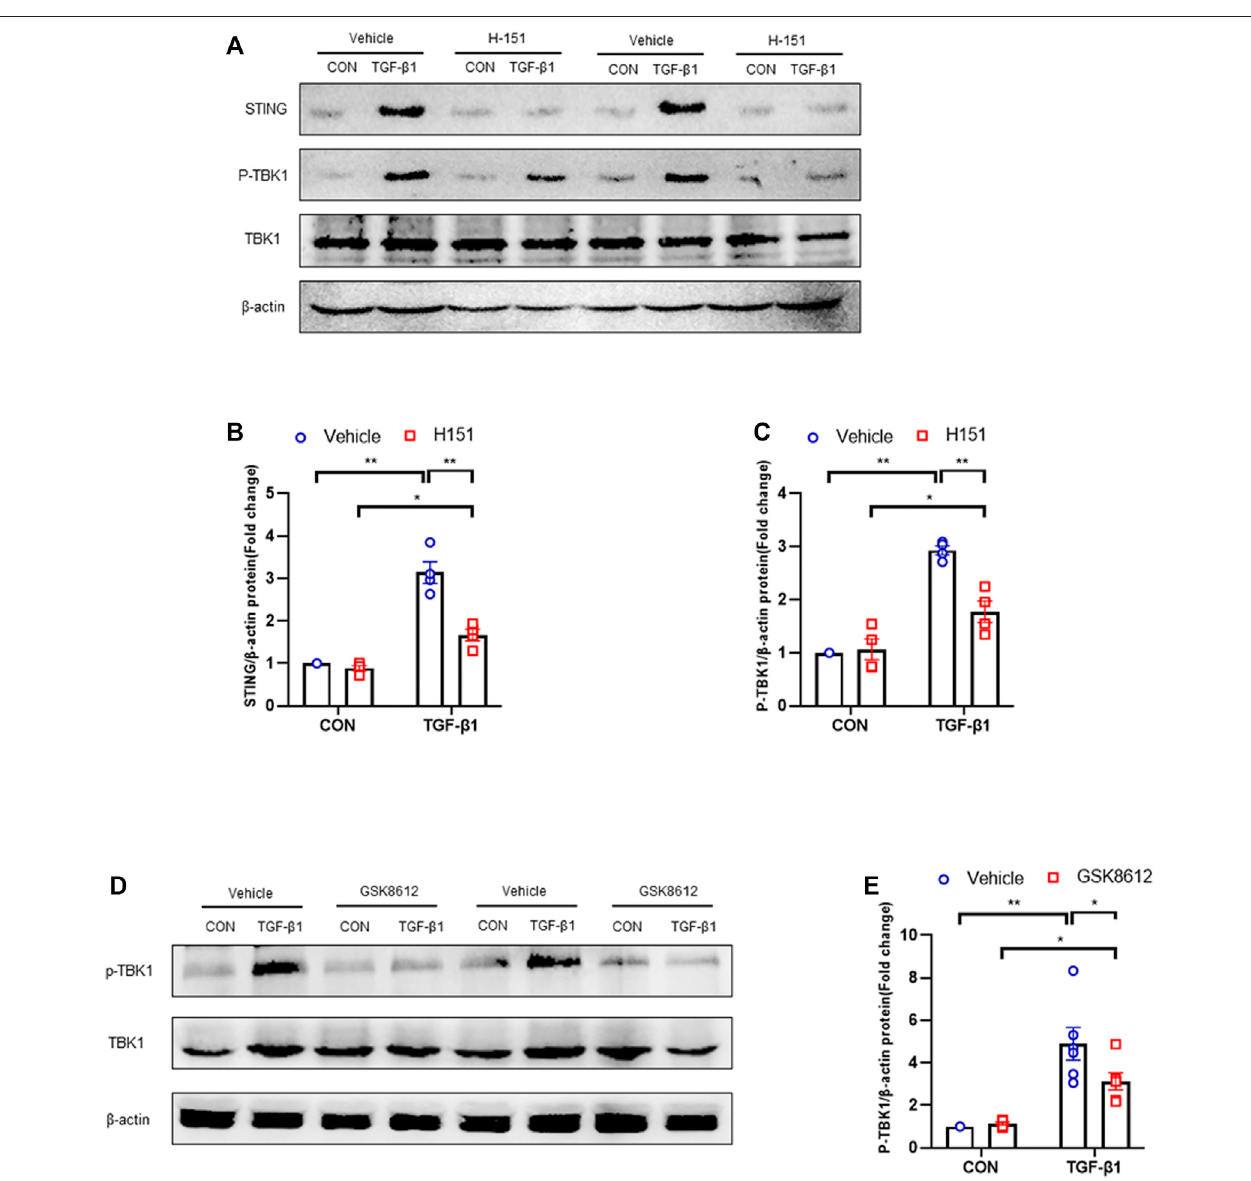
FIGURE9| H-151orGSK8612 treatment inhibitsSTING/TBK1signalingactivation invitro . (A) RepresentativewesternblotsshowSTING andTBK1protein levels in cultured monocytes treated by TGF- β 1 or (and) H-151. (B,C) Quantitative analysis of STING and TBK1 protein expression. (D) Representative western blots show TBK1 protein levels in cultured monocytes treated by TGF- β 1 or (and) GSK8612. (E) Quantitative analysis of TBK1 protein expression. ** p < 0.01, * p < 0.05; n = 4 – 6 in each group.